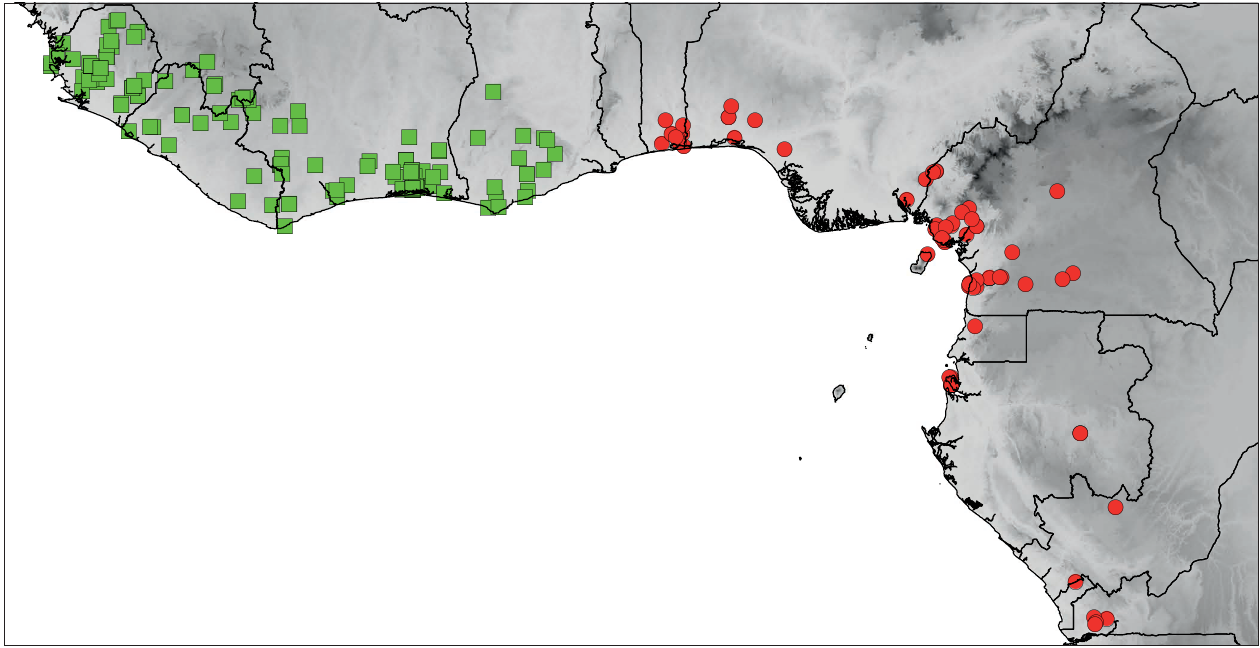
Figure 12 – Distribution of Rhigiocarya nervosa (green squares) and of R. racemifera (red dots). Map created with ArcMap 10.7.1 (ArcGIS Desktop v.10.7.1; Esri 2019). © Esri and its licensors, all rights